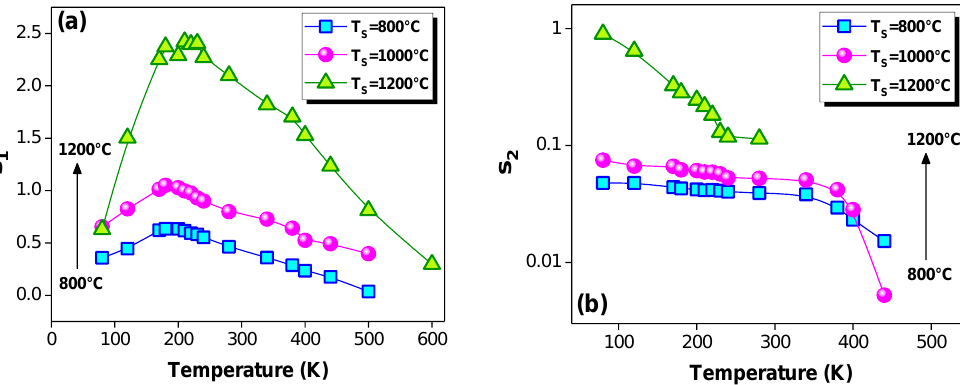
Figure 3. Temperature dependences of ( a ) ‘s 1 ’ and ( b ) ‘s 2 ’ at different sintering temperatures. The W H , W M , W M1 and W M2 were calculated by using Equation (3) (for W H ), Equation (4) (for W M , W M1 and W M2 ) and the obtained slopes from the linear fit of [1-s 1 ] (for W H and W M ) and [1-s 2 ] (for W M1 and W M2 ) against the temperature.